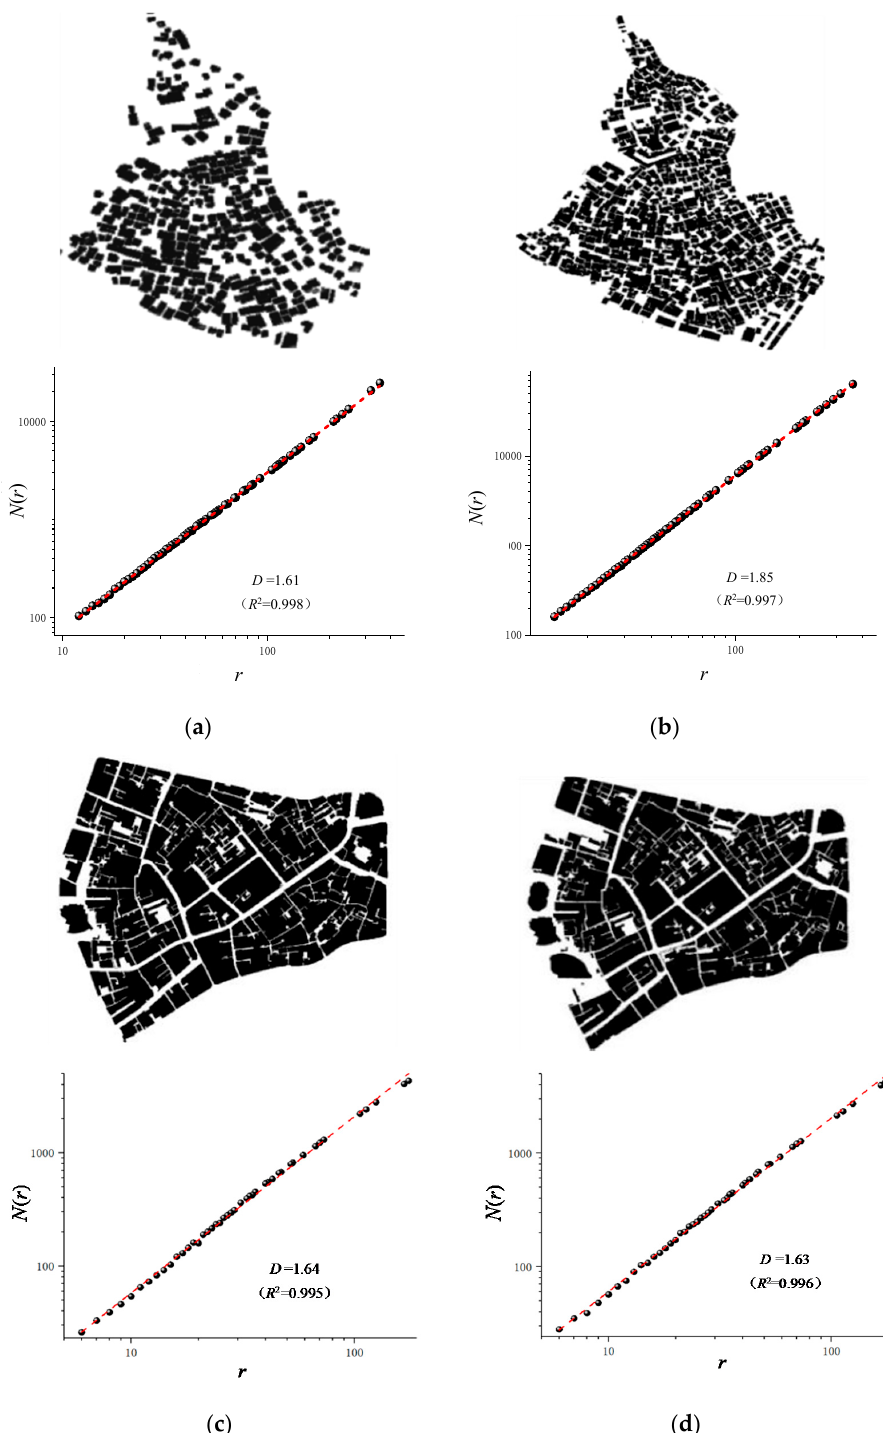
Figure 3. Land-use maps of Zengcuoan settlement and the corresponding fractal dimensions in ( a ) 2000 and ( b ) 2018, and the land-use maps of Yingping settlement and the corresponding fractal dimensions in ( c ) 2000 and ( d ) 2017.